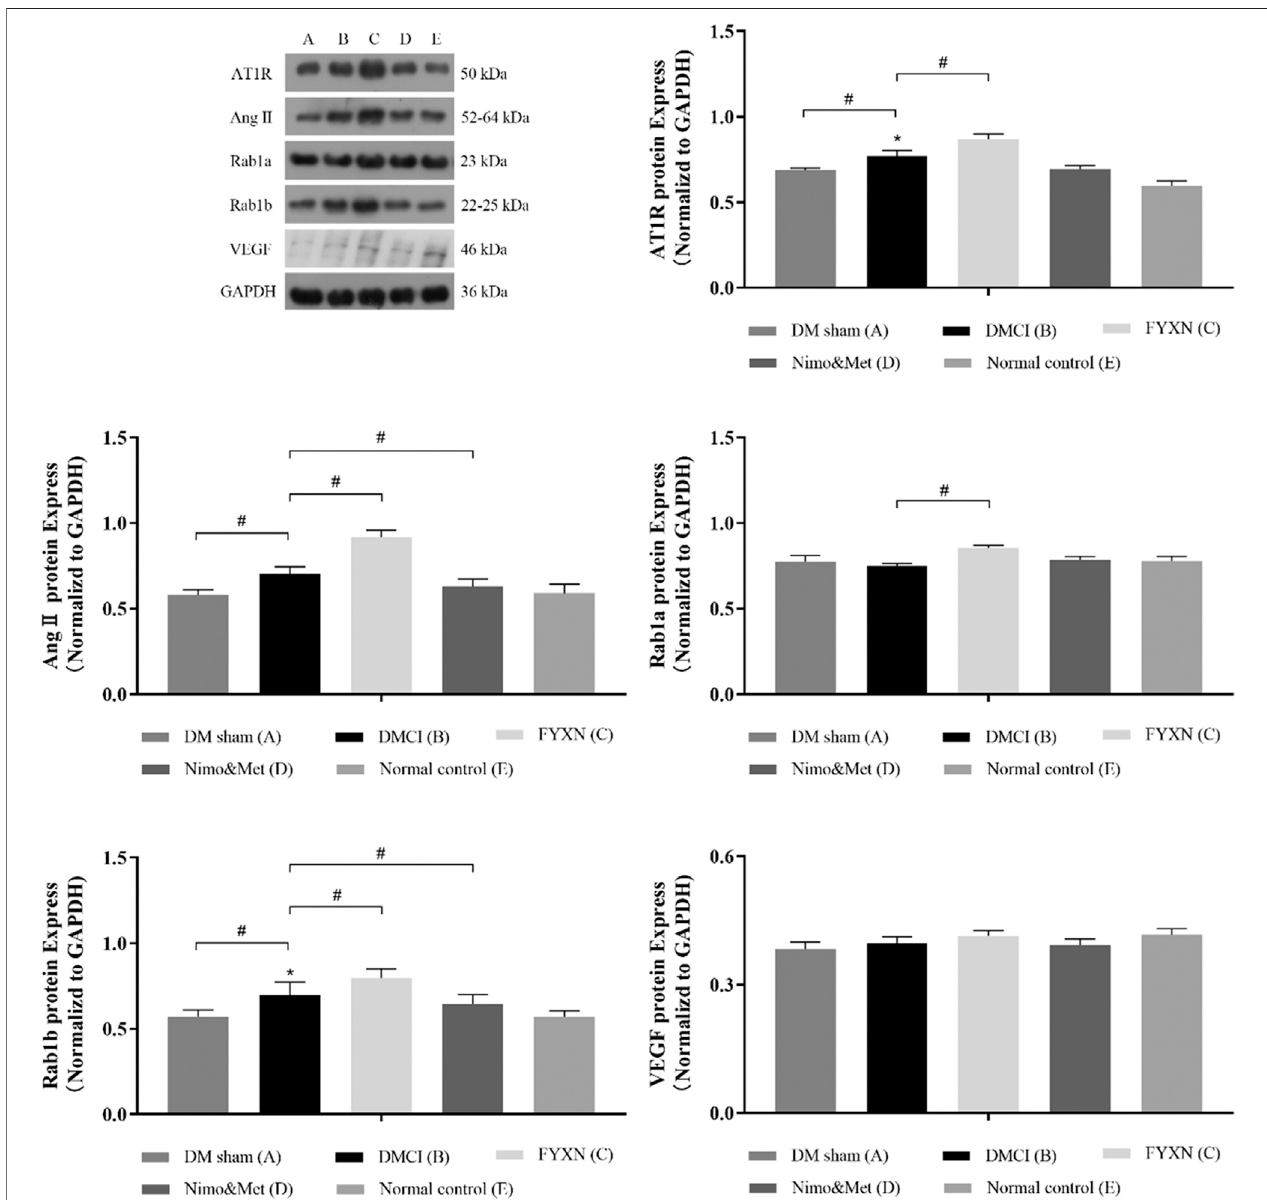
FIGURE 8 | Effects of FYXN treatment on the expression of AT1R, Ang II, Rab1a, Rab1b and VEGF protein in ischemic cerebral cortex tissue. Their expressions were detected by Western Blotting. * p < 0.05 compared with NC group; # p < 0.05 compared with DMCI group.